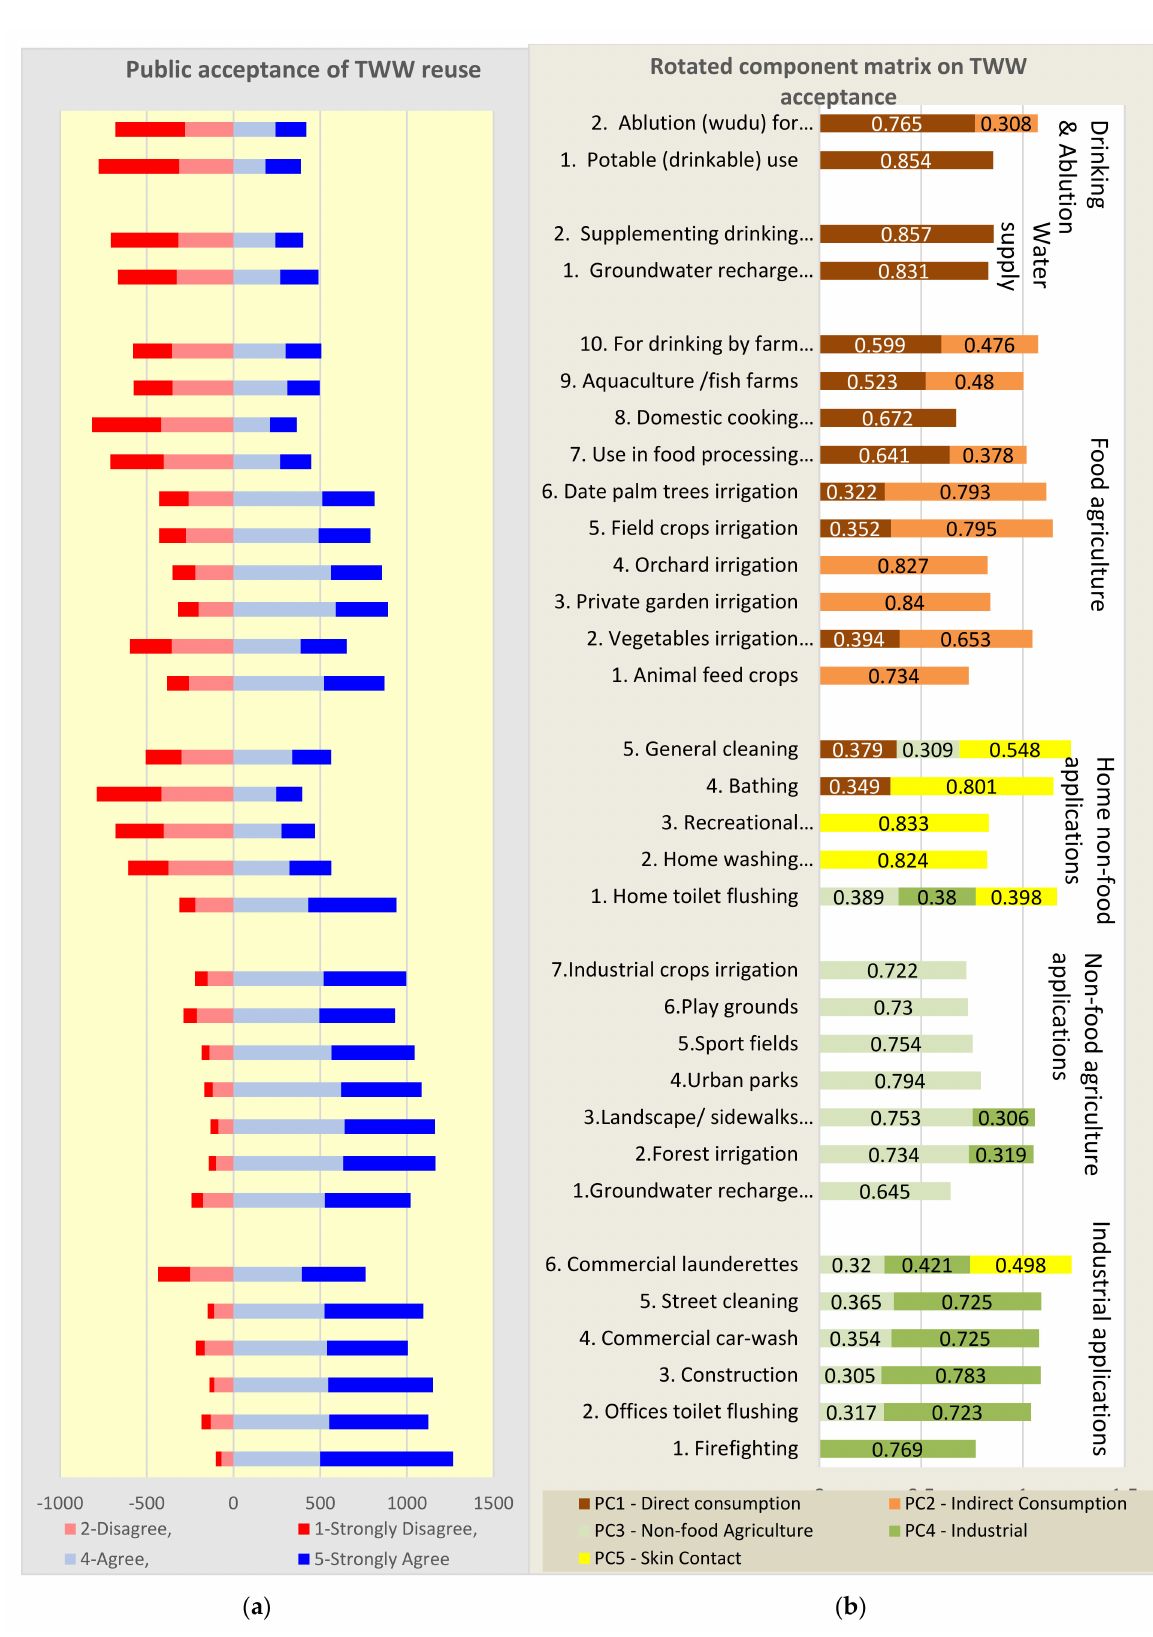
Figure 5. ( a ) Public acceptance of TWW reuse; ( b ) Results of PCA analysis of TWW acceptance